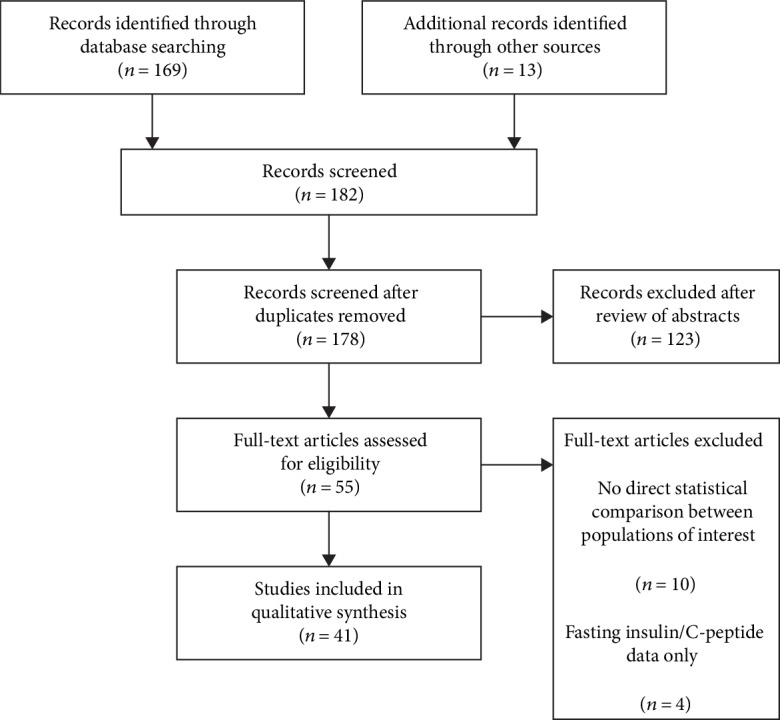
Study selection flow chart. Adapted from PRISMA 2009 [22].